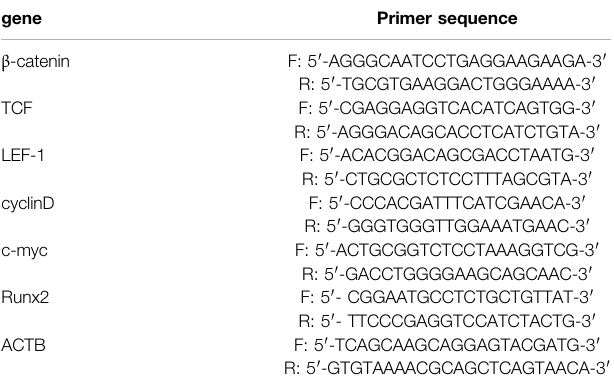
TABLE 1 | Prime sequences for RT-PCR. gene Primer